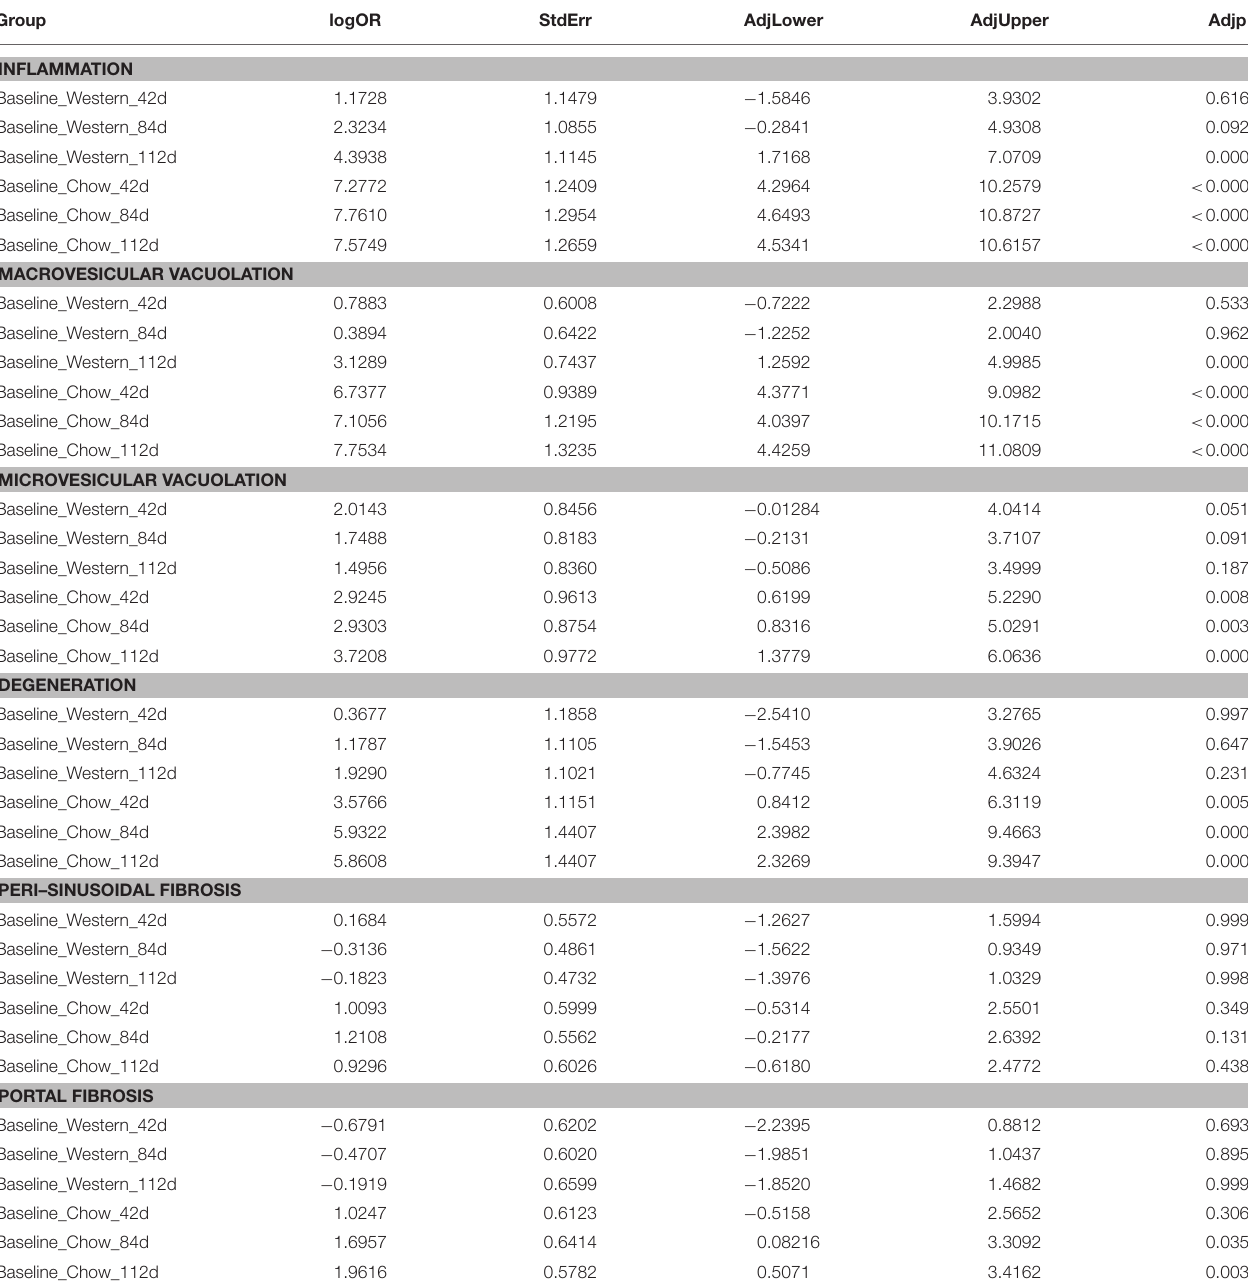
TABLE 3 | Statistical analysis of regression study (all groups vs. Western_Baseline). Group logOR StdErr AdjLower AdjUpper